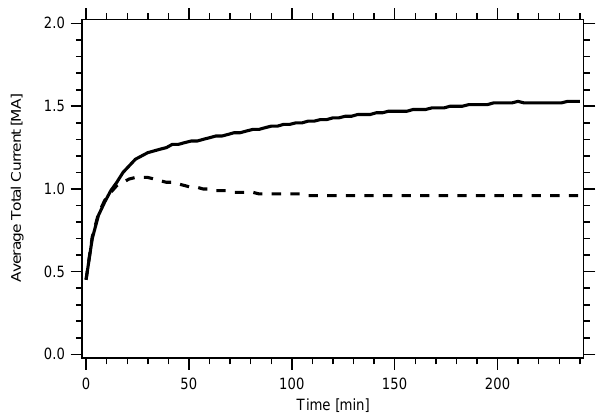
Fig. 1. Evolution of the Birkeland total current during a 4-h simula- tion of nominal southward IMF conditions using the SWMF model with (solid line) and without (dotted line) coupling to the